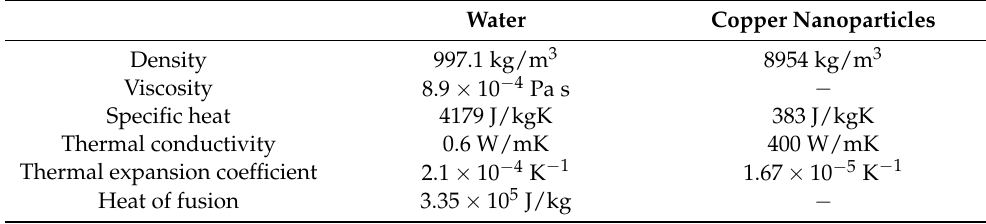
Table 1. Thermophysical and transport properties for the solvent and the nanoparticles.